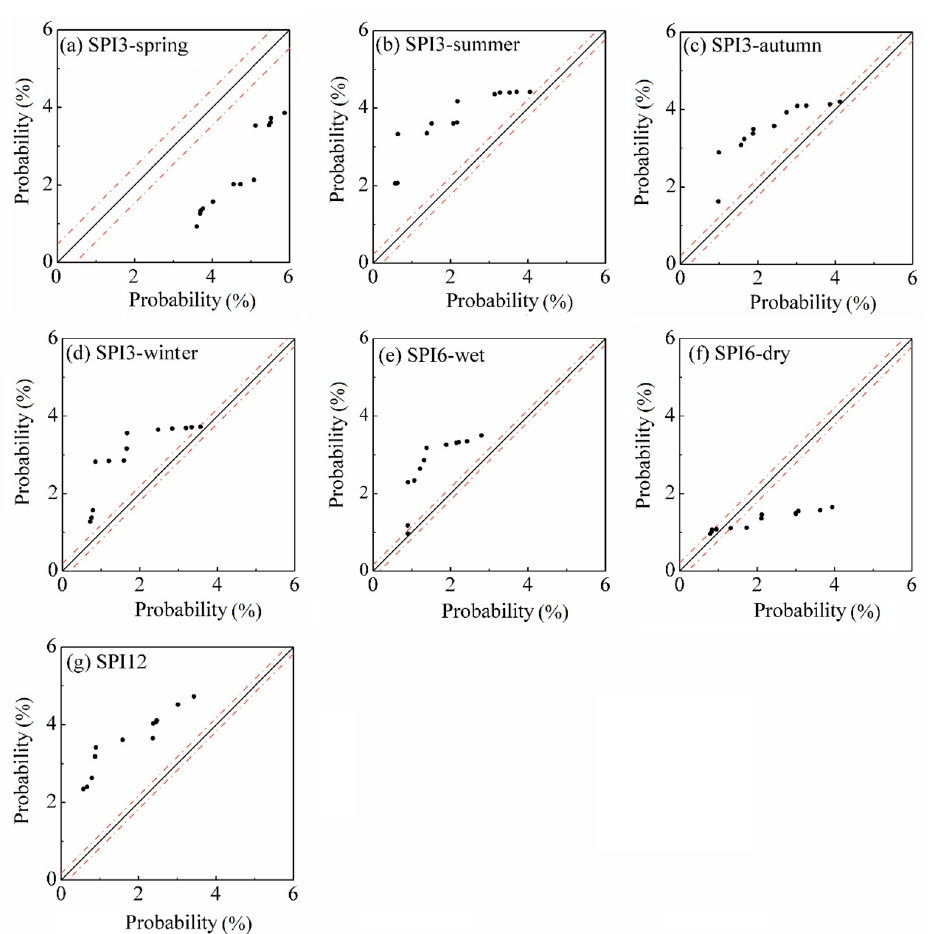
Figure 5. The trends of probability of extreme droughts at various time scales using the moving- window method. The x-axis is for probability of extreme droughts from 1962-1991 to 1974-2003 in ascending order; the y-axis is for probability of extreme droughts from 1975-2004 to 1987-2016 in ascending order.